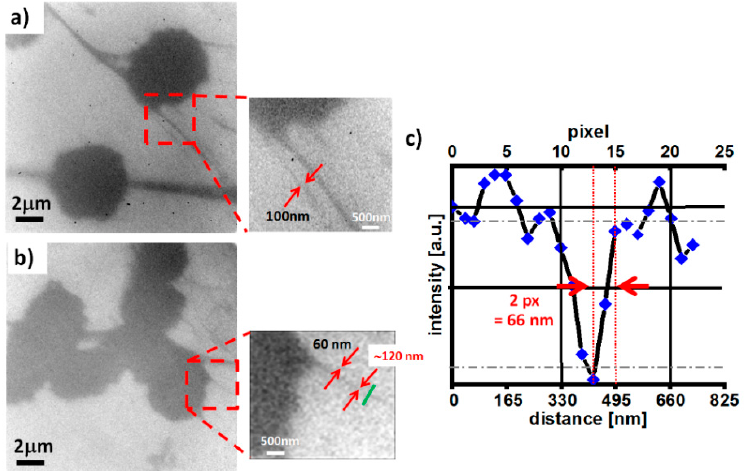
Figure 13. ( a , b ) EUV images of CT 26 fibroblast cells. Small features approaching the microscope resolution are shown in the zoomed insets. The zoom in ( b ) depicts the line profile through the smallest visible feature (indicated with a green line), showing a 0–95% slope rise of 66 nm. ( c ) Shows the KE test calculated over the green line of the ( b ) inset. Figure modified, based on [71,76]. Diatoms